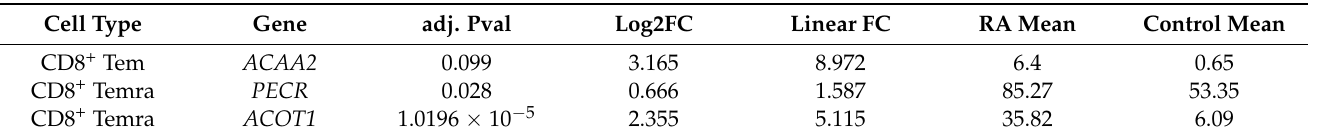
Table 11. Fatty acid metabolism DEGs in untreated RA T cell subsets. Means are calculated from DESeq2 normalized counts.